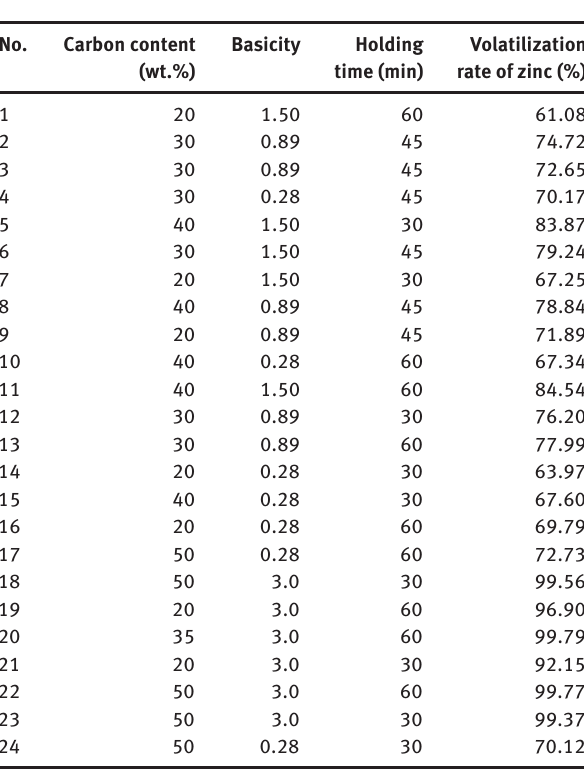
Table 2: Experimental conditions and